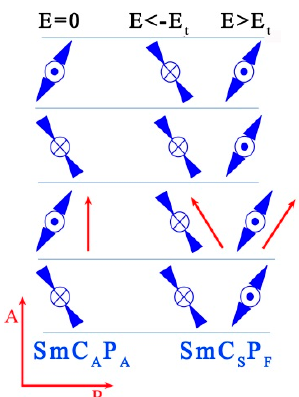
Figure 4. Schematic picture of molecular organization in neighbouring layers: the first column shows the original SmC A P A phase, the second and the third column demonstrate the reorientation of molecules in the applied electric field +E and –E in the SmC S P F phase. The perpendicular arrows in the bottom left corner show the orientation of polarizers, and the red arrows mark the orientation of the average molecular axis.